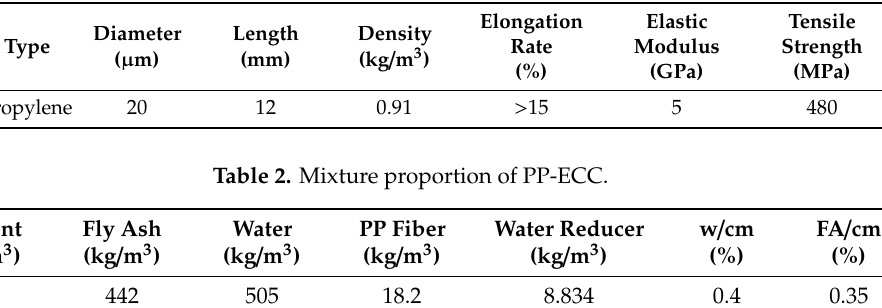
Table 1. Properties of polypropylene fibers for the engineered cementitious composite (ECC).